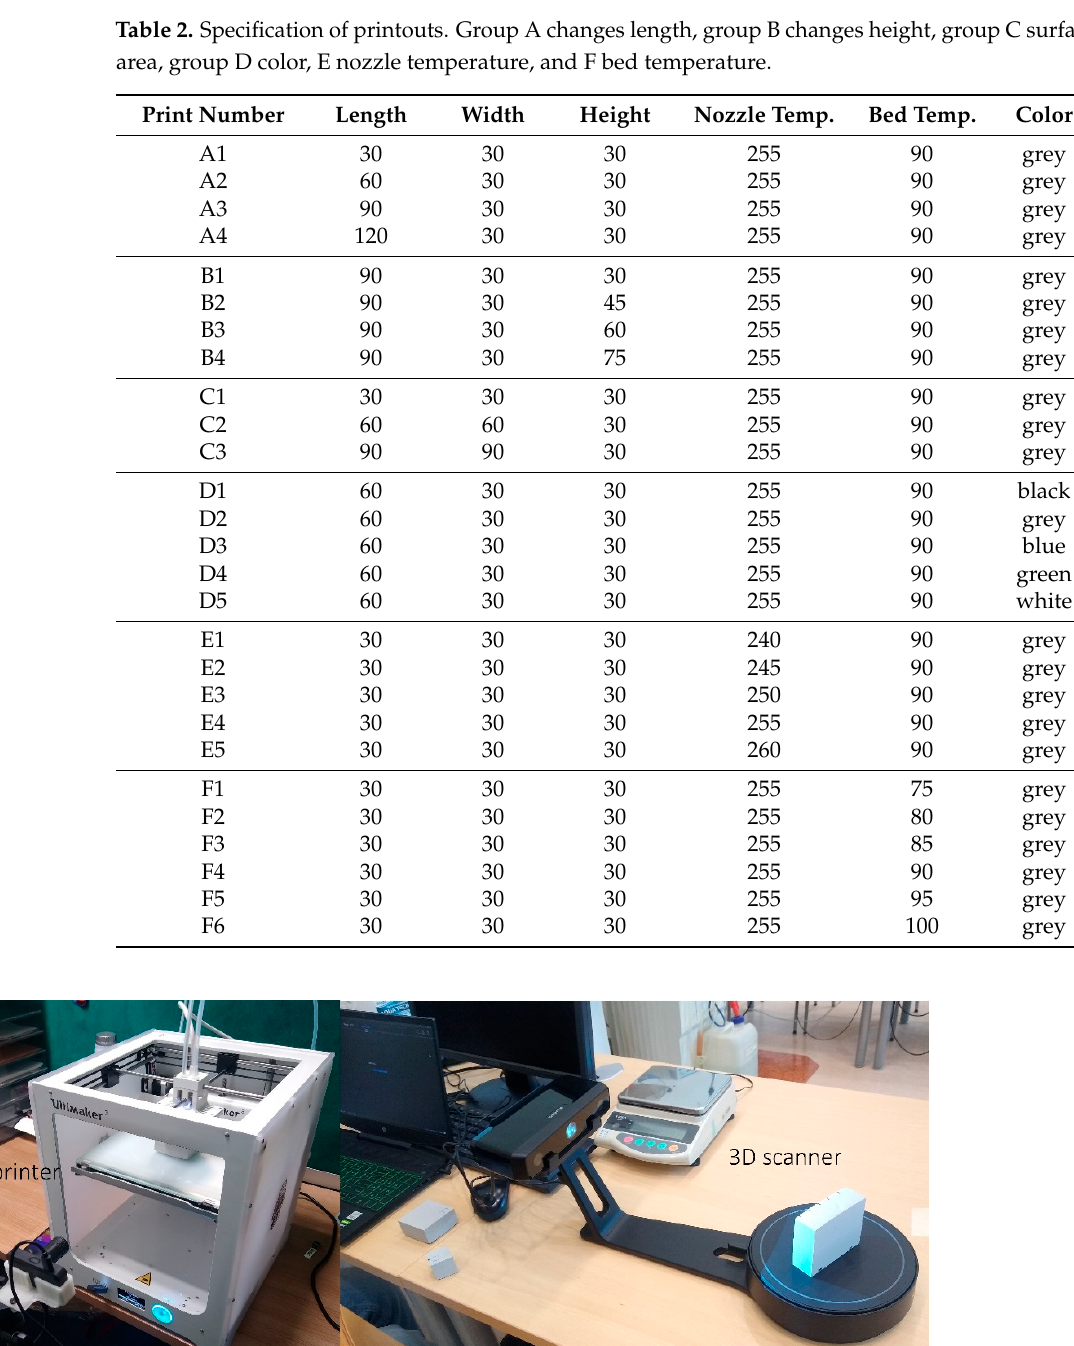
Figure 5. Experimental setup. ( Left ): 3D printer with infrared camera placed before. ( Right ): 3D scanner with the object on it.